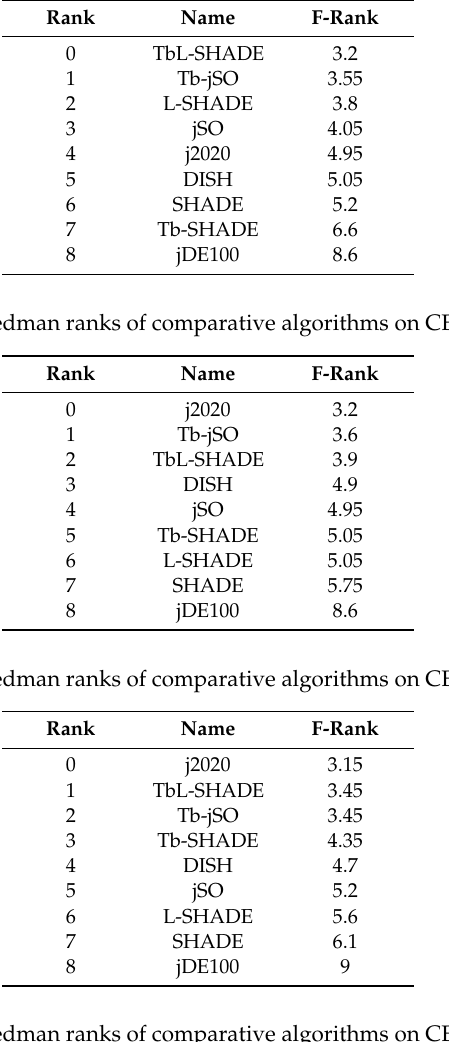
Table 35. The Friedman ranks of comparative algorithms on CEC2020 in 5 D .